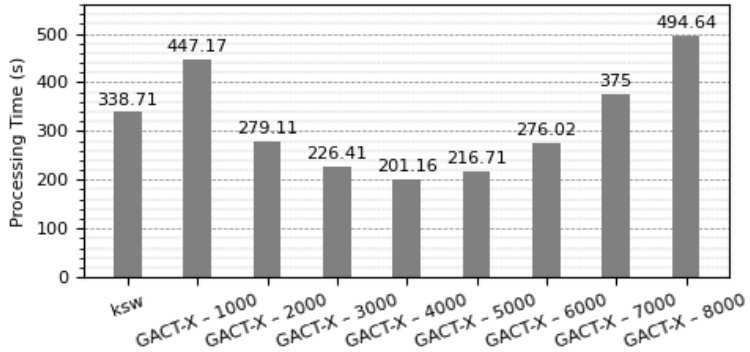
Figure 8. Processing times for the ksw function from Minimap2 and for GACT-X with different tile sizes for first-anchor-extended sub-sequences (for the first 100,000 reads of the simulated dataset). The first bar corresponds to the original ksw function. All other bars correspond to GACT-X’s implementations configured to different tile sizes (from 1000 to 8000 bases). The shortest processing time was measured for a tile size of